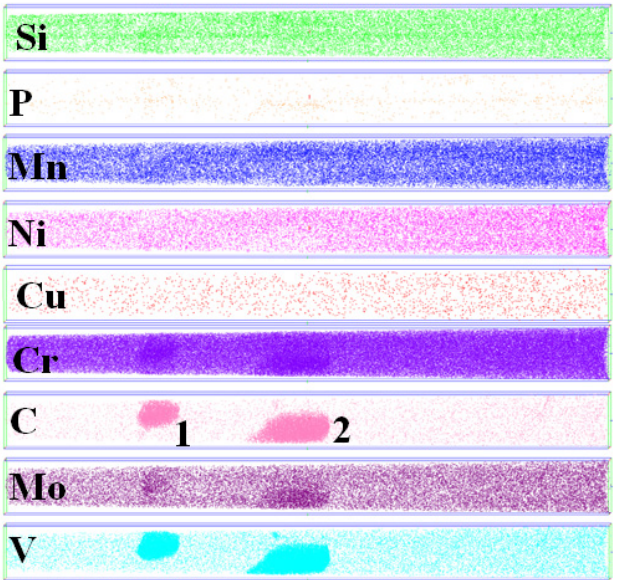
Figure 4. APFIM results of as received Cr–Mo–V steel. The phosphorus, copper and other alloying and polluting elements are distributed in the matrix, only around vanadium carbides the chromium and molybdenum enriched slightly.